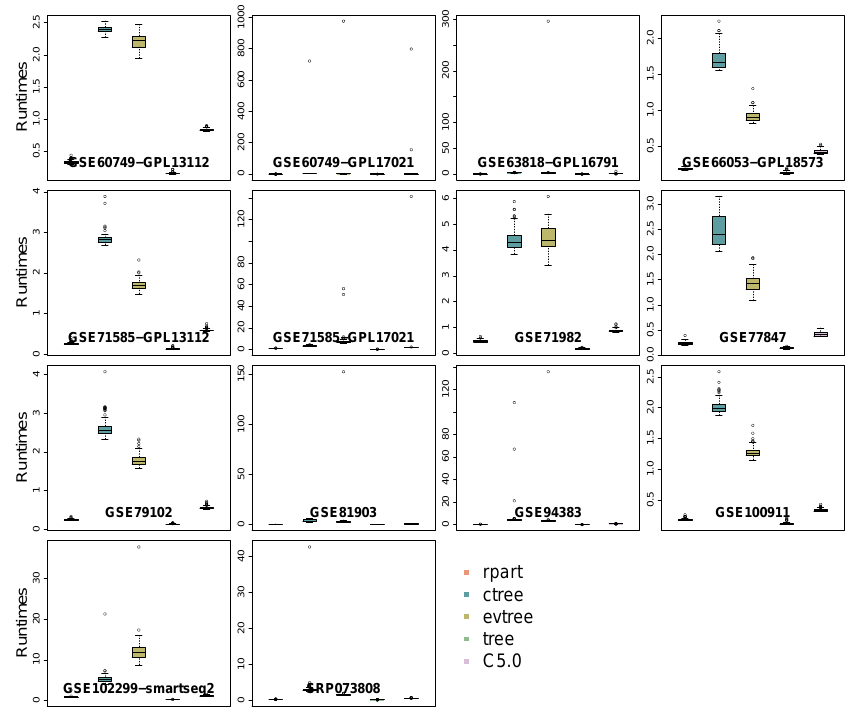
Figure 7. Methods’ Runtime scores on all data